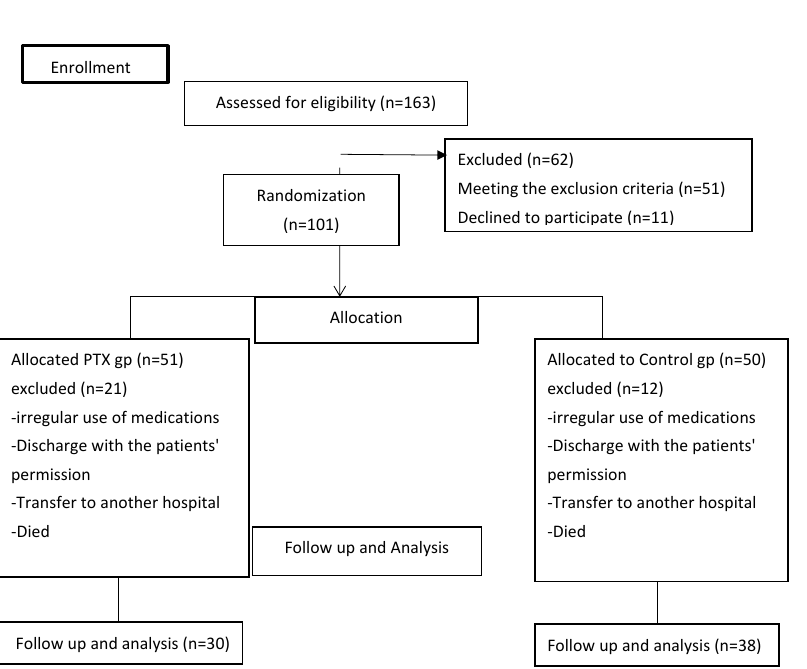
Figure 2. A CONSORT diagram of the Figure 2: A CONSORT diagram of the study